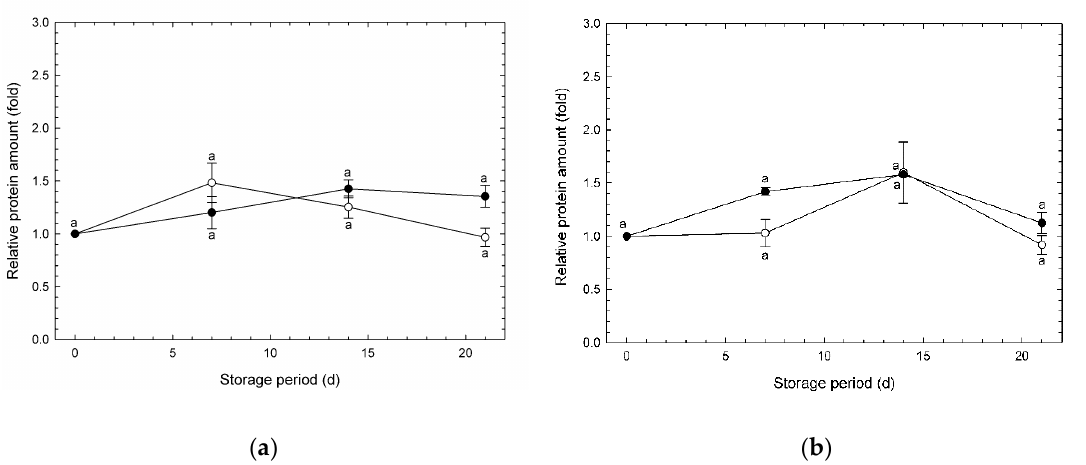
Figure 6. Relative amount of cytochrome c oxidase (COX) in broccoli heads during storage at 1 °C. ( a ) Experiment #1:  , normoxia;  , O 2 /CO 2 = 2.5%/6.0% (+ N 2 to 100%). ( b ) Experiment #2:  , normoxia;  , O 2 /CO 2 = 2.5%/0.0% (+ N 2 to 100%). Values are means ± SE of three biological replicates. Significant differences ( p < 0.05) are denoted by different